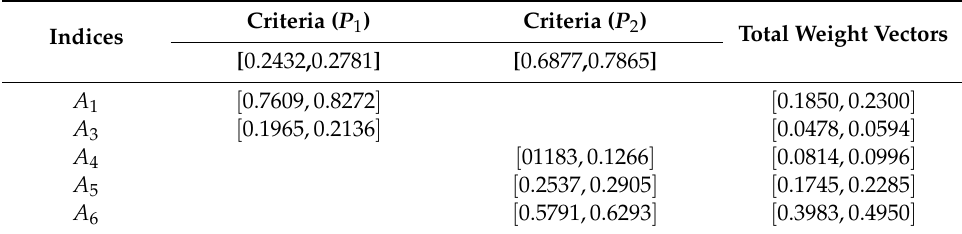
Table 4. Interval total weight vectors of the i -AHP